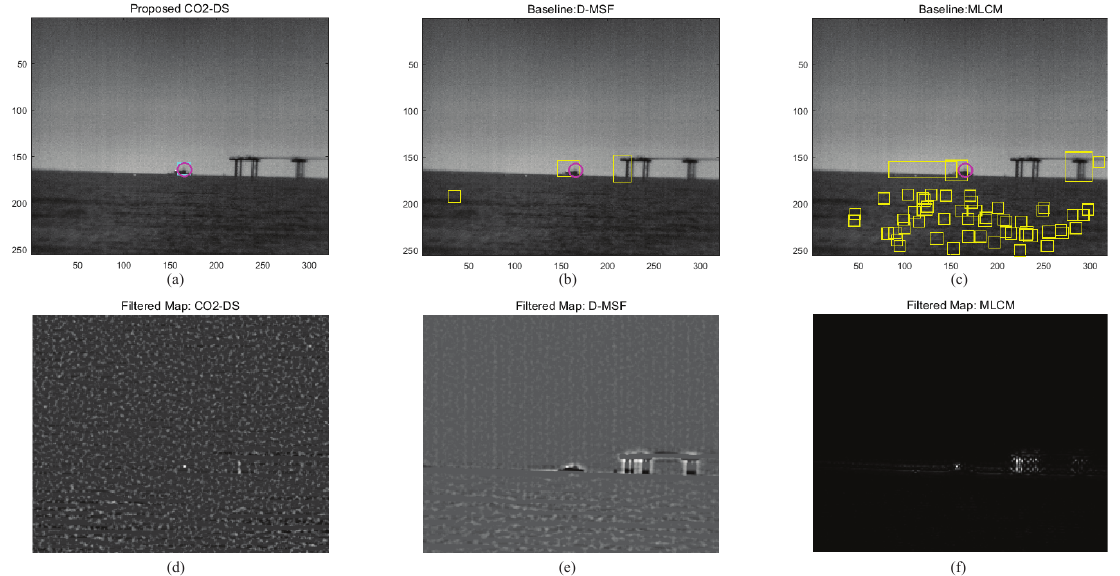
Figure 17. Comparative detection examples for sea-clutter backgrounds: ( a – c ) detection results, ( d – f ) filtered